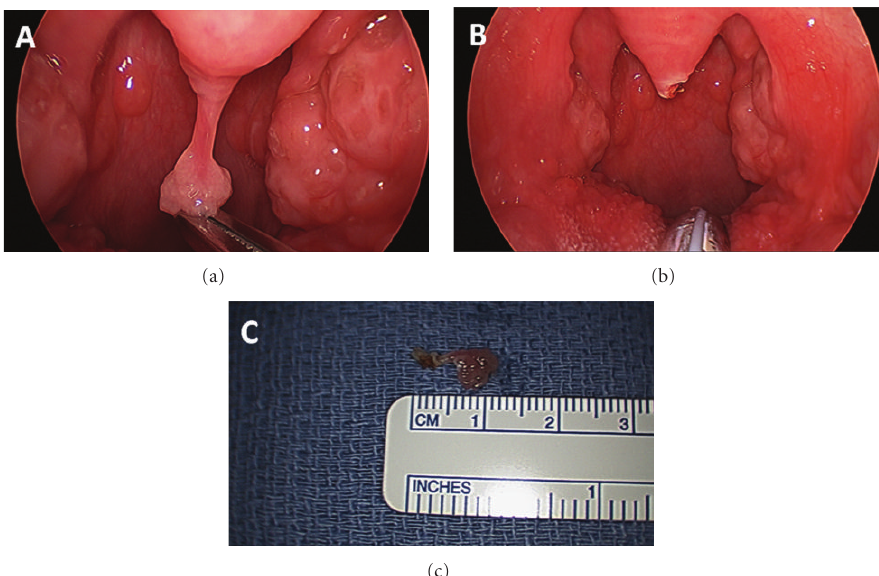
Figure 1: (a) Telescopic view of the pharynx reveals a pedunculated lesion emanating from the tip of the uvula. (b) Telescopic view of the pharynx after excision of the uvular lesion. (c) The squamous papilloma removed from the oral cavity.